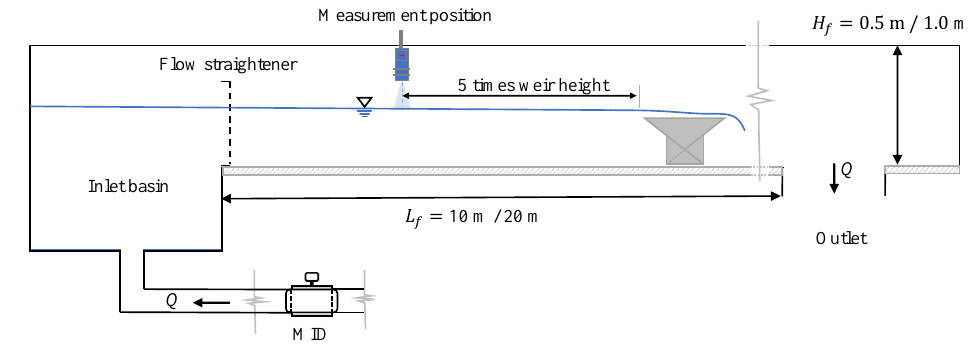
Figure 3. Schematic experimental set-up for both